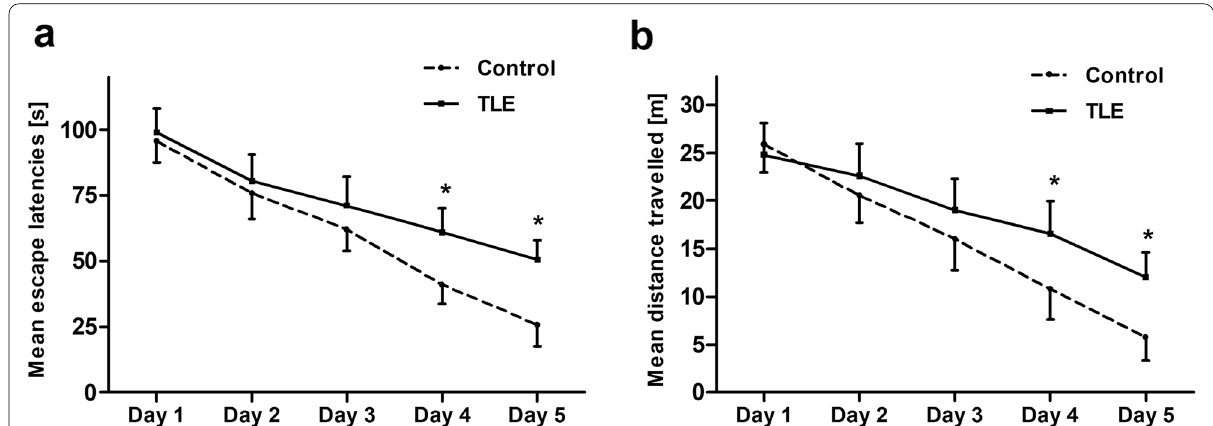
Fig. 1 Cognitive dysfunction in rats with temporal lobe epilepsy (TLE). There were significantly higher escape latencies ( a ) and longer distances travelled ( b ) in the TLE rats on days 4 and 5 of training in Morriz water maze. n